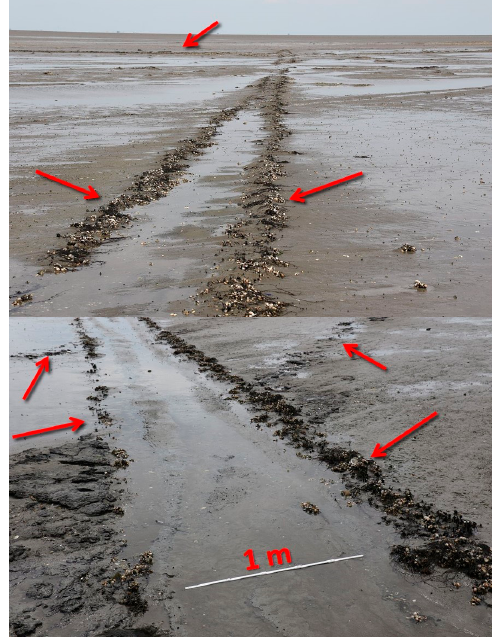
Figure 10. Two photographs of traces of historical ditches in the area of interest, taken at low tide during a field excursion in June 2017. The red arrows in both panels mark manifestations of the (former) ditches’ rims that can be seen on SAR imagery. Photographs: M. Gade.